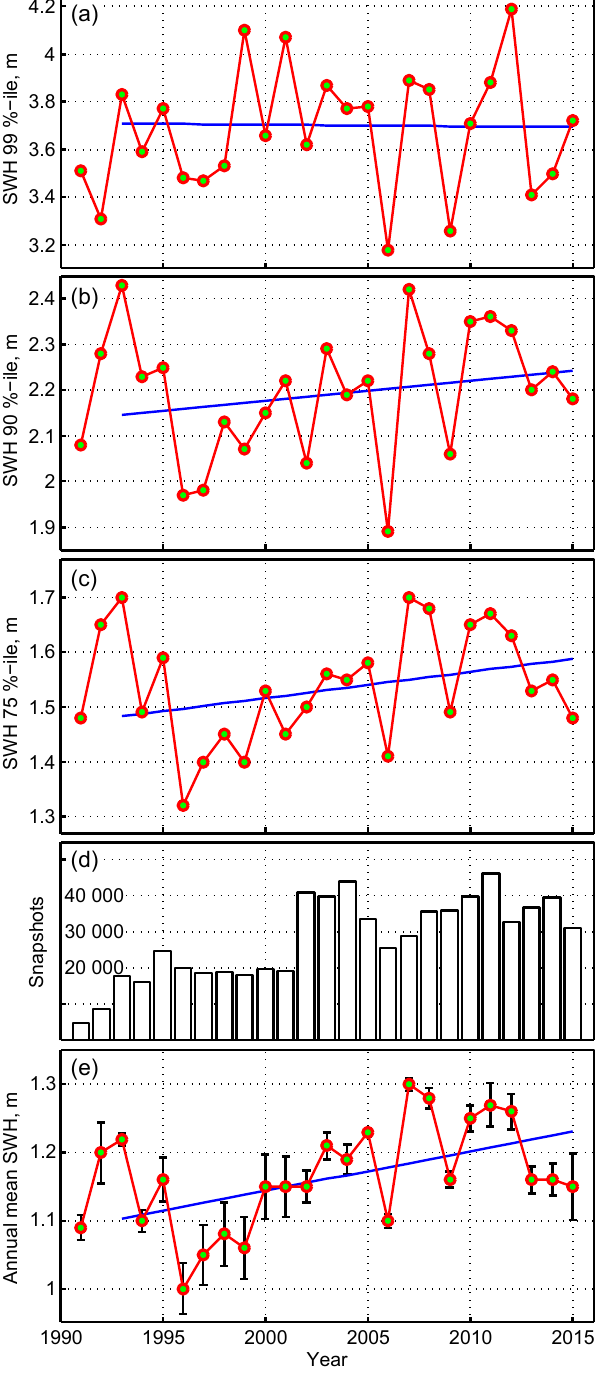
Figure 3. Wave climate derived from the satellite altimetry in terms of the annual mean SWH in the entire Baltic Sea (e) ; 75th per- centile (c) , 90th percentile (b) , and 99th percentile (a) of single SWH records. The straight lines show the linear trends (regression line fitted to 1993–2015). The smaller panel (d) indicates the count of altimetry snapshots